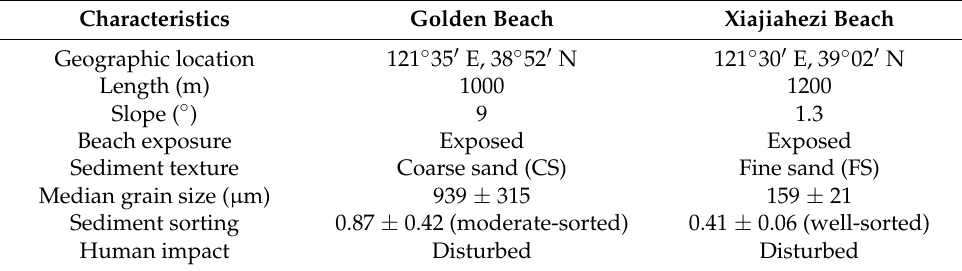
Figure 1. Map of sampling sandy beaches. Table 1. Environmental characteristics of the study locations.